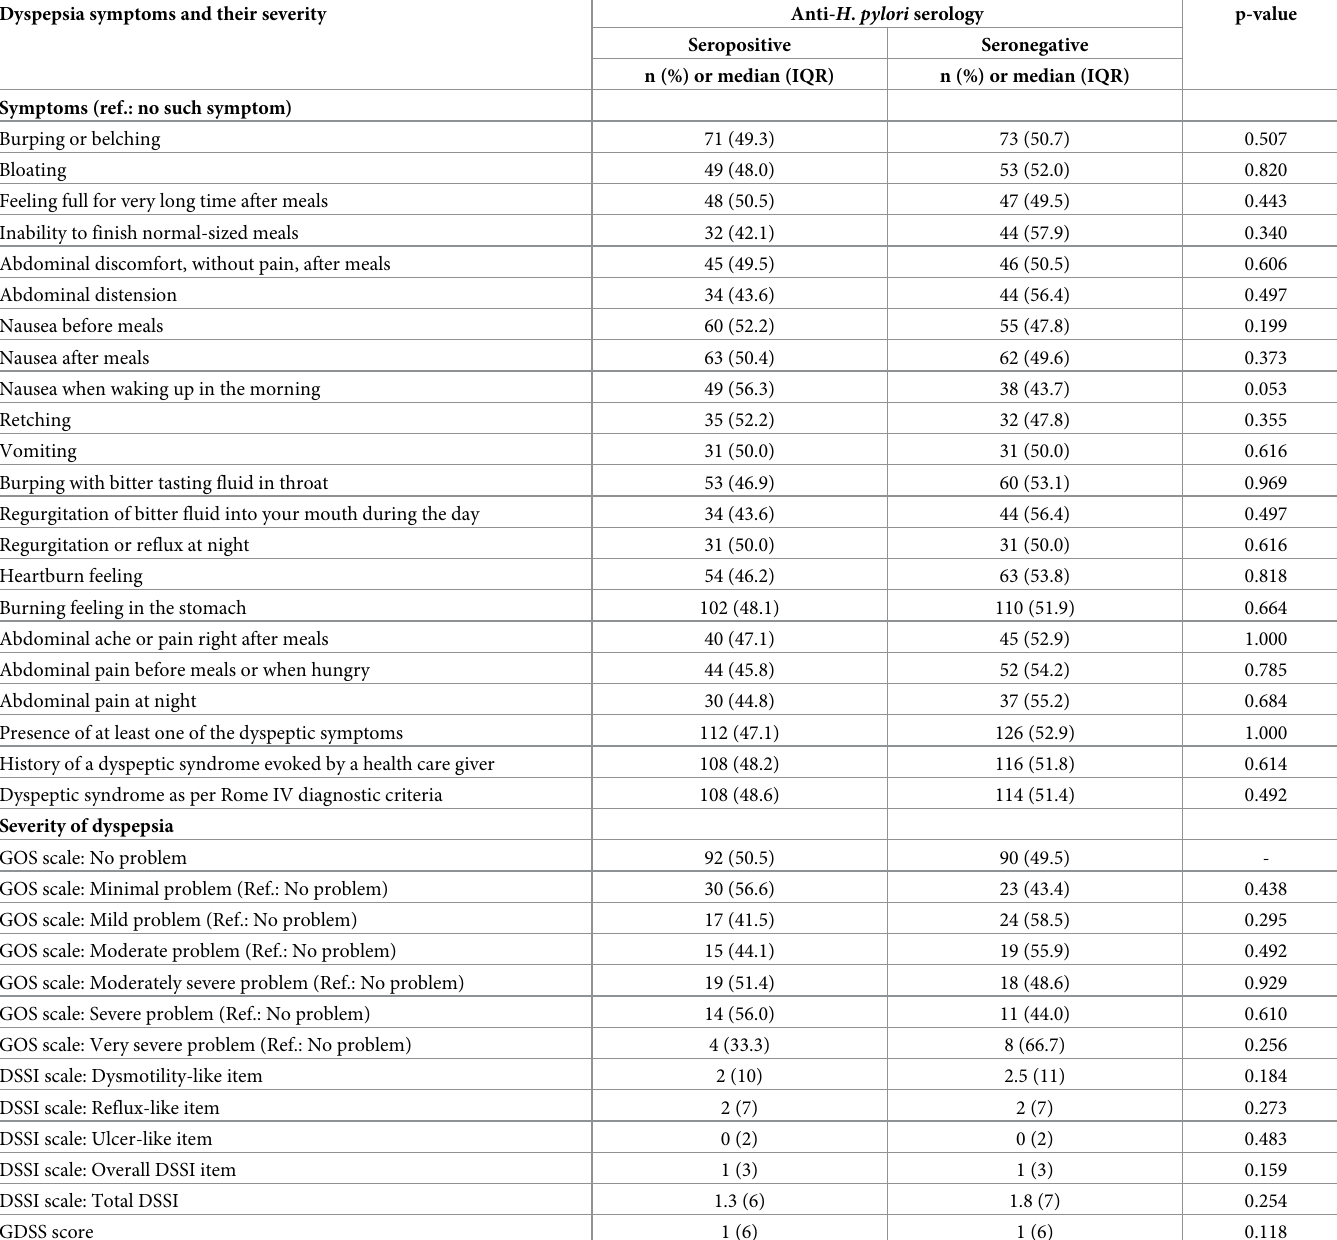
Table 6. Baseline clinical characteristics of study participants (n = 425). Dyspepsia symptoms and their